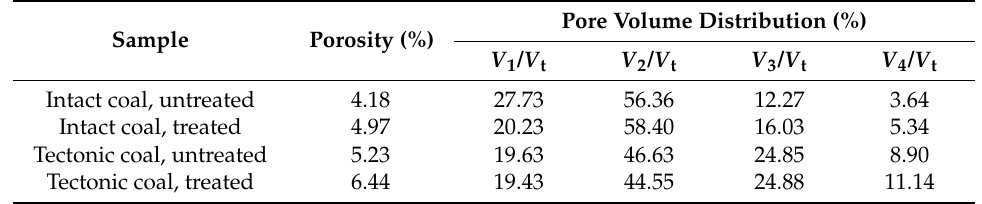
mesopores; V 4 = pore volume of macropores; V t = total pore volume.